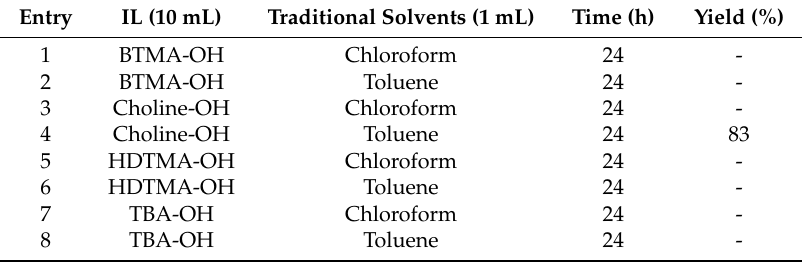
Table 3. The synthesis of 3,5-bis(biphenyl-4-yl)-4-butyl-4 H -1,2,4-triazole ( 7a ) in